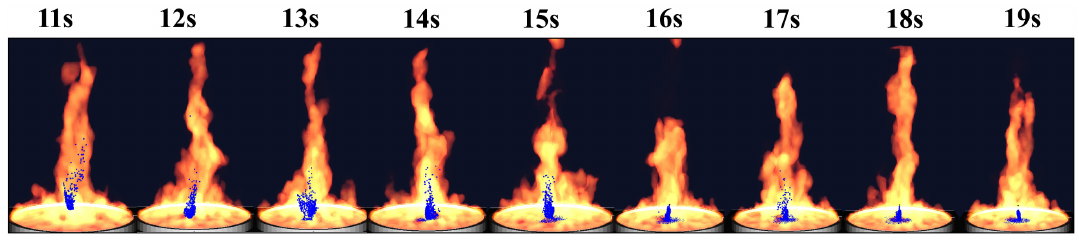
Figure 5. Flow of water droplets over the fuel surface after the suppression.